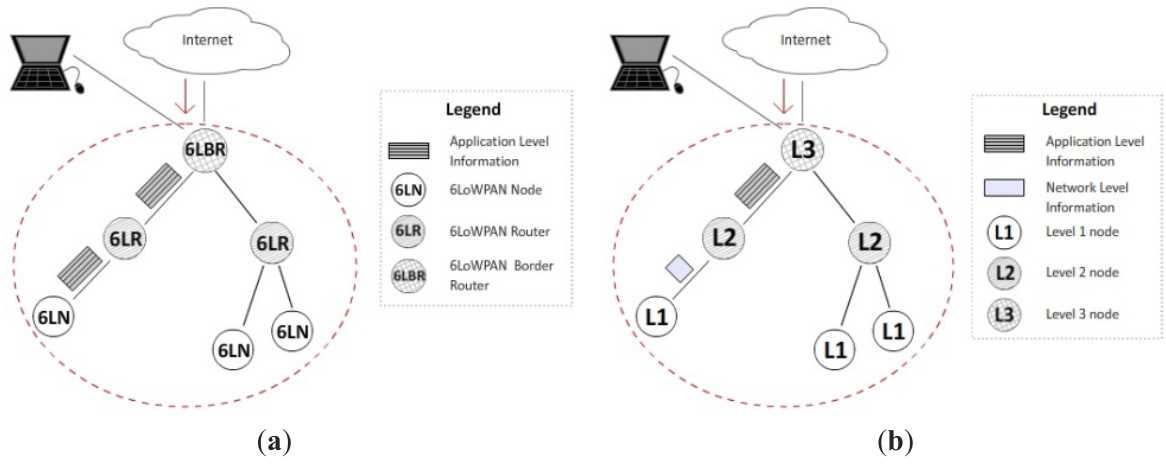
Figure 11. Communication models: ( a ) CoAP model; ( b ) proposed